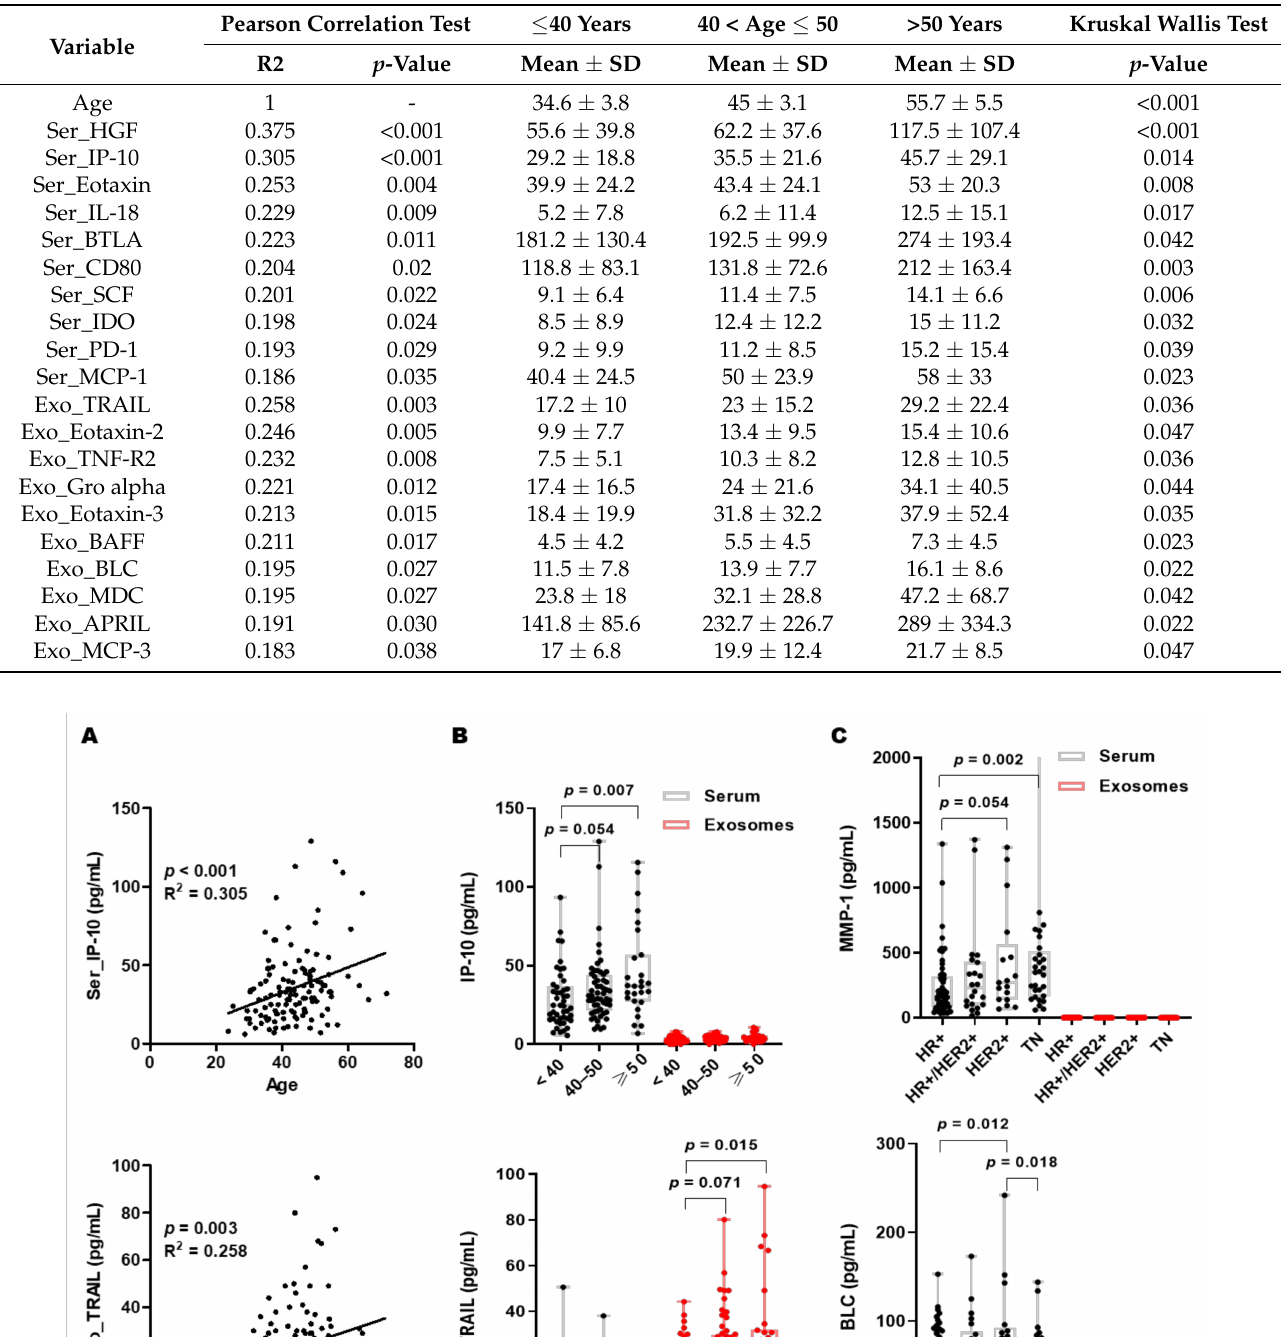
Table 2. Relationships between biomarker expression and age.